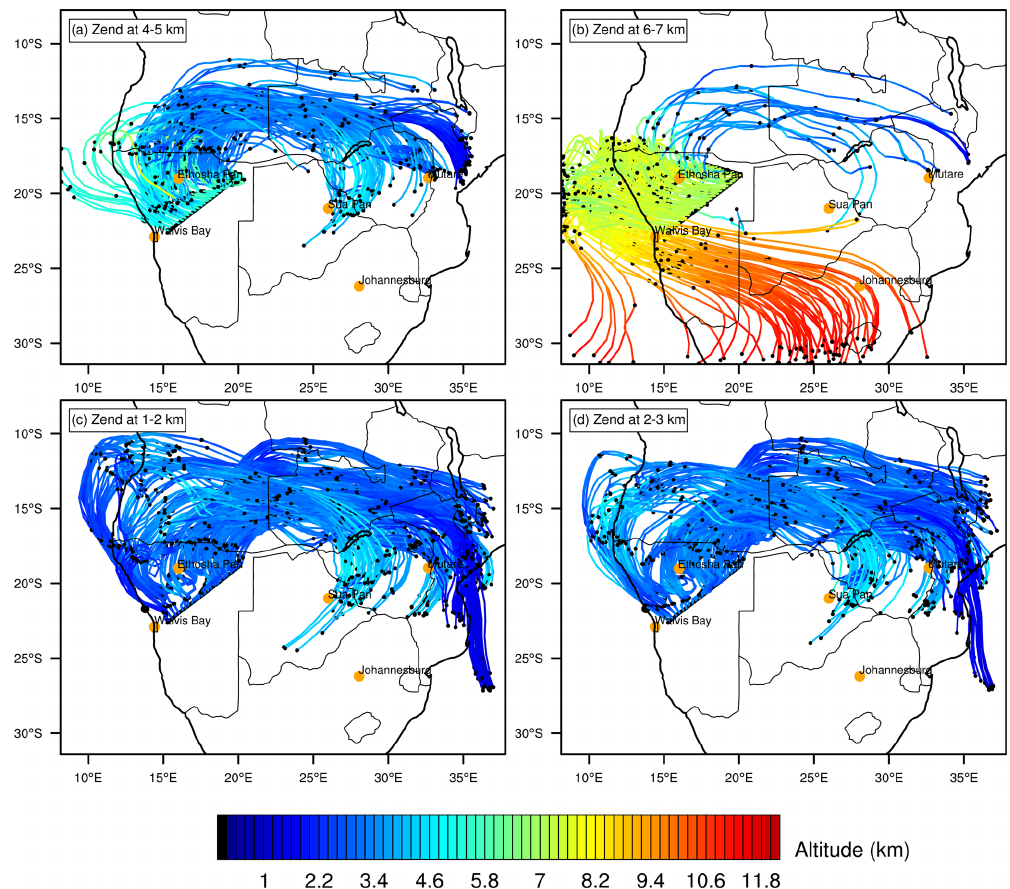
Figure 10. 102h backward trajectories ending at 09:00UTC 5 September 2017 along the F06 flight track and at altitudes between (a) 4 and 5kma.m.s.l., (b) 6 and 7kma.m.s.l., (c) 1 and 2kma.m.s.l. and (d) 2 and 3kma.m.s.l. Dots on the backward trajectories are spaced at 24h intervals. One backward trajectory out of 20 is